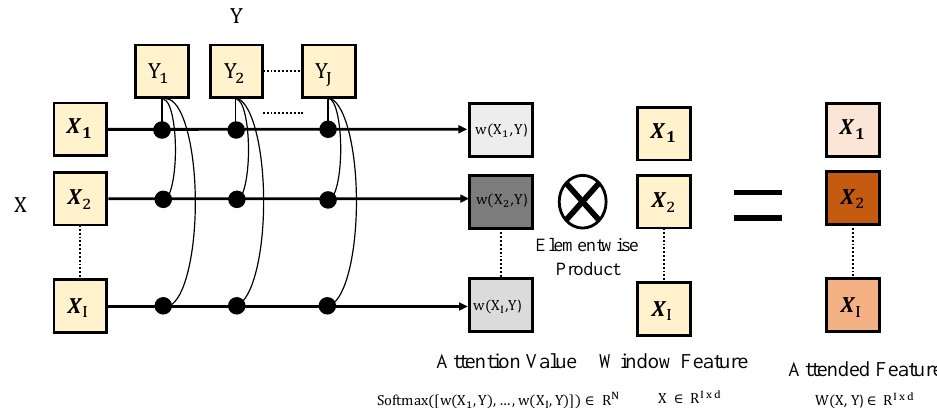
Figure 4. Illustration of Window Attention. The WA is performed on TWA and HWA according to the window